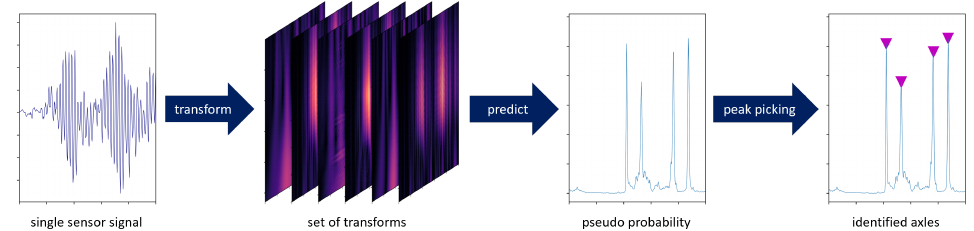
Figure 1. VAD process, from left to right: acceleration signals from a single sensor, set from different transformations of the signal, localization estimation as pseudo probabilities, and identified axles classified by a peak-finding algorithm. Signal section used is the same for each plot with horizontal axis in the